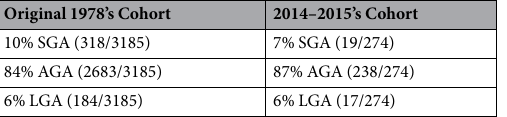
Table 1. Percentage of SGA, AGA and LGA in the original cohort and current cohort.